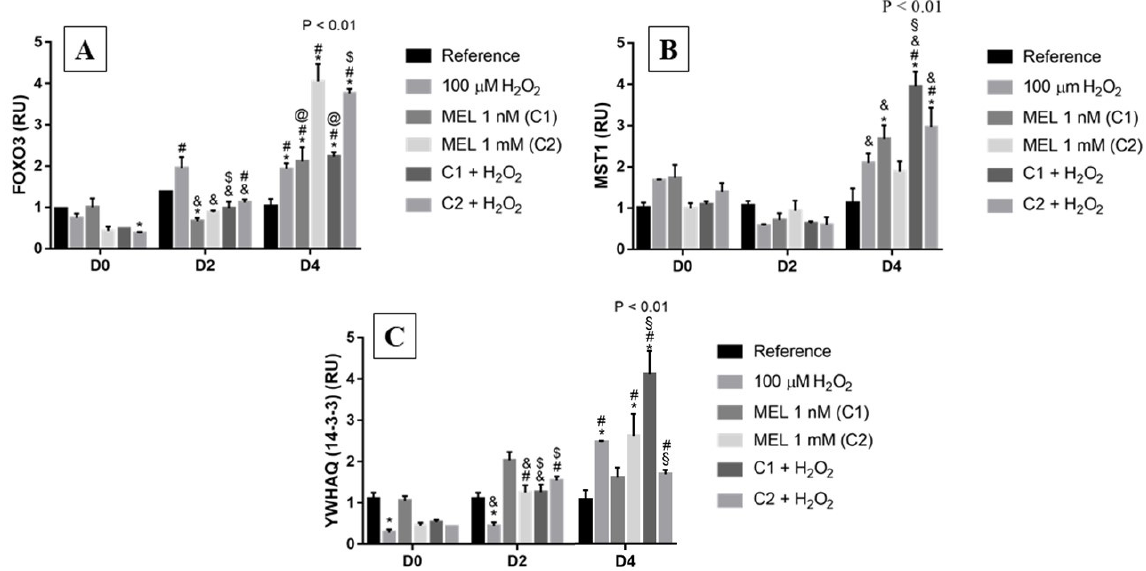
Figure 2. Relative expression of the FOXO3 pathway in K562 erythroid cells: ( A ) FOXO3 gene expression, ( B ) MST1 gene expression, and ( C ) YWHAQ (14-3-3) gene expression. Reference: K562 cells without induction of oxidative stress and not treated with melatonin; 100 µM H 2 O 2 : Cells under stress induction with hydrogen peroxide; C1: cells treated with 1 nM melatonin; C2: cells treated with 1 mM melatonin; C1 + 100 µM H 2 O 2 and C2 + 100 µM H 2 O 2 : sets of cells treated with the same melatonin concentrations associated with stress induction; D0: before the differentiation, D2: beginning of cell differentiation; D4: maximum of the differentiation process. * Effects of treatments within each period compared to the respective reference groups; # Effect of the incubation period within each treatment compared to their counterparts in D0; & Effect of the incubation period between D2 and D4 within the same treatment; § Effect of C1 compared to other treatments within the same period; @ Effect of C2 compared to other treatments within the same period; $ Effect of melatonin when compared to 100 µM H 2 O 2 . Test performed: GLM with 2-way ANOVA design, complemented by Bonferroni test.